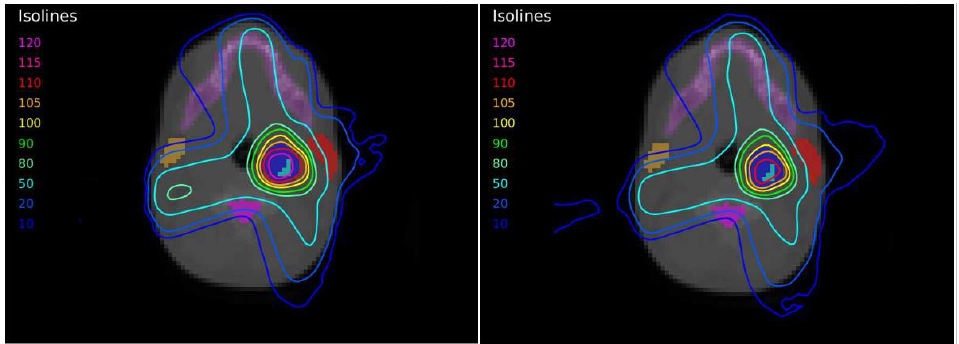
Figure 5. Dose distribution for Case 1 by applying the dose-painting technique under EARL1 ( left ) and EARL2 ( right ) accreditations.